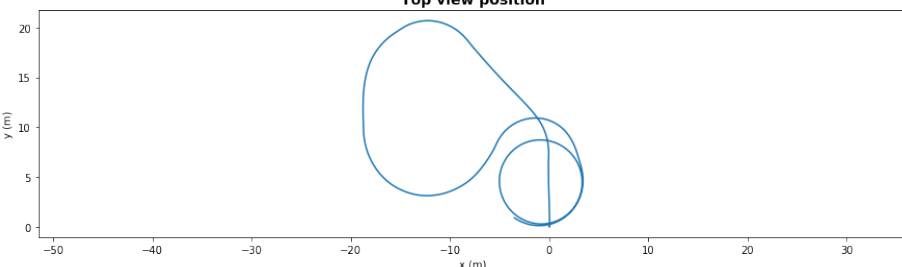
Figure 9. waypoint mission—path with mild degradation and reallocation.